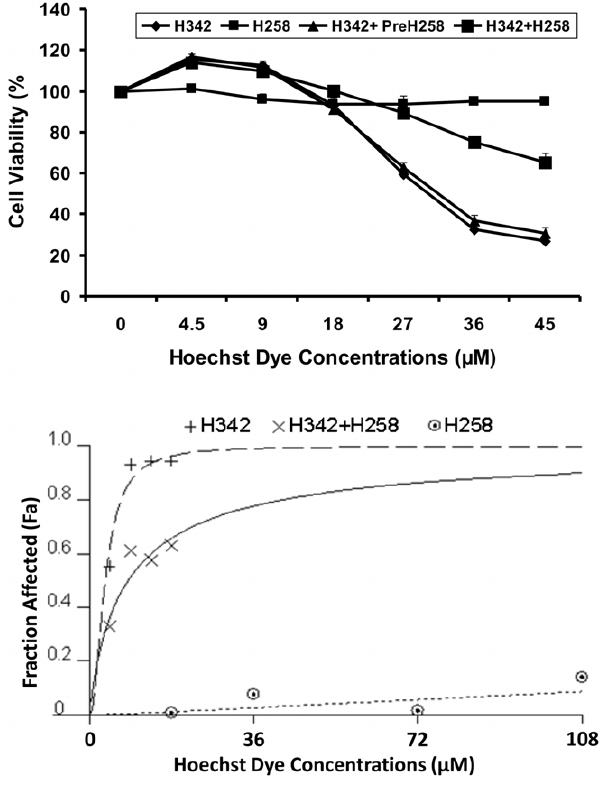
Figure 4. Antagonistic effect of H258 on H342-induced cell death in H2373 cells. A, Cell viability was determined by MTT assay after H2373 cells were treated by H342 or H258 alone, H258 pretreatment for 1 h followed by H342 treatment, or combination of H342 + H258 for different times. B, Antagonistic effect between H342 and H258 was analyzed by Calcusyn software to generate a dose response curve. Fa represents the fraction of cells that is growth inhibited in response to H342 and/or H258. This is calculated as 1 2 fraction of surviving cells. Fa values for each treatment were used to conduct synergy analysis by CalcuSyn software as described in Materials and Methods.